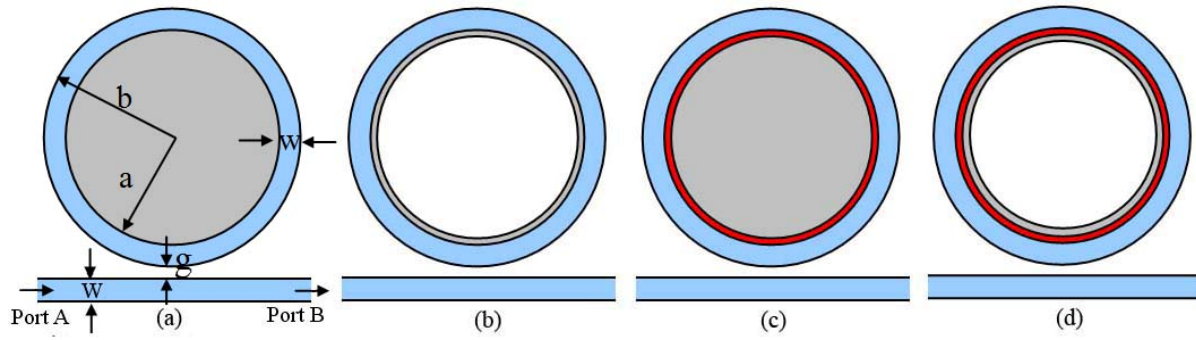
Figure 3. Simulation model of the microring sensor. (a) Conventional microring sensor with a dielectric core (colored in grey). (b) The dielectric sample is attached to the inner side of the microring. (c) A layer of metamaterial (colored in red) is added to the inner side of the microring with a dielectric core. (d) The dielectric sample is attached to the inner side of the microring adhere to the metamaterial layer.